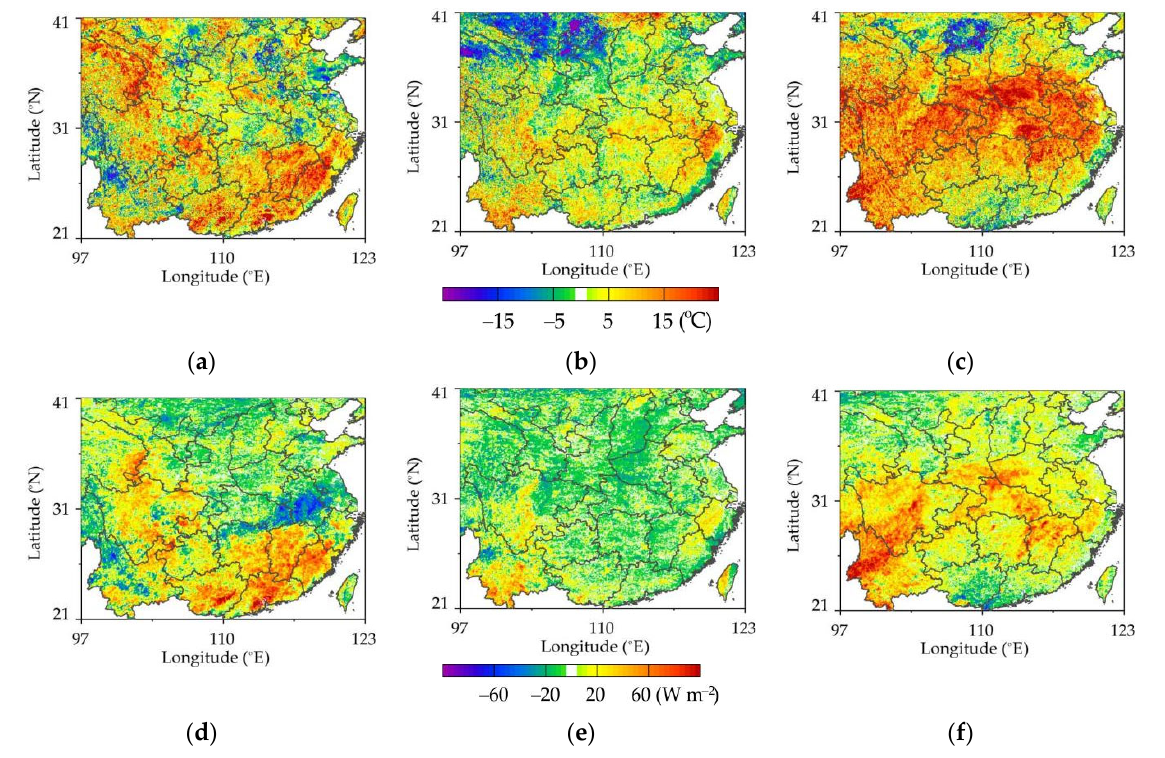
Figure 15. Comparison of LST and ET in 2022 with those in 2021, where ( a – c ) are the distributions of the LST difference in late June, late July, and middle August, respectively, and ( d – f ) are the distributions of the ET difference in late June, late July, and middle August, respectively.